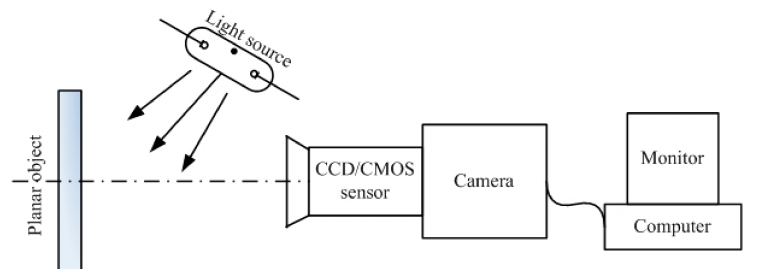
Figure 3. Due to its simple experimental setup, 2D-DIC is ideal to measure the in-plane deformation of an object. The technique is based on the illumination of the object under test using a light source: the image of the surface of the object is captured by a digital camera: the comparison of the undeformed and deformed surface images through numerical digitization software allows for the precise measurement of the in-plane deformation. High-quality cameras are required to obtain accurate measurement of strain. Figure reproduced from [38].